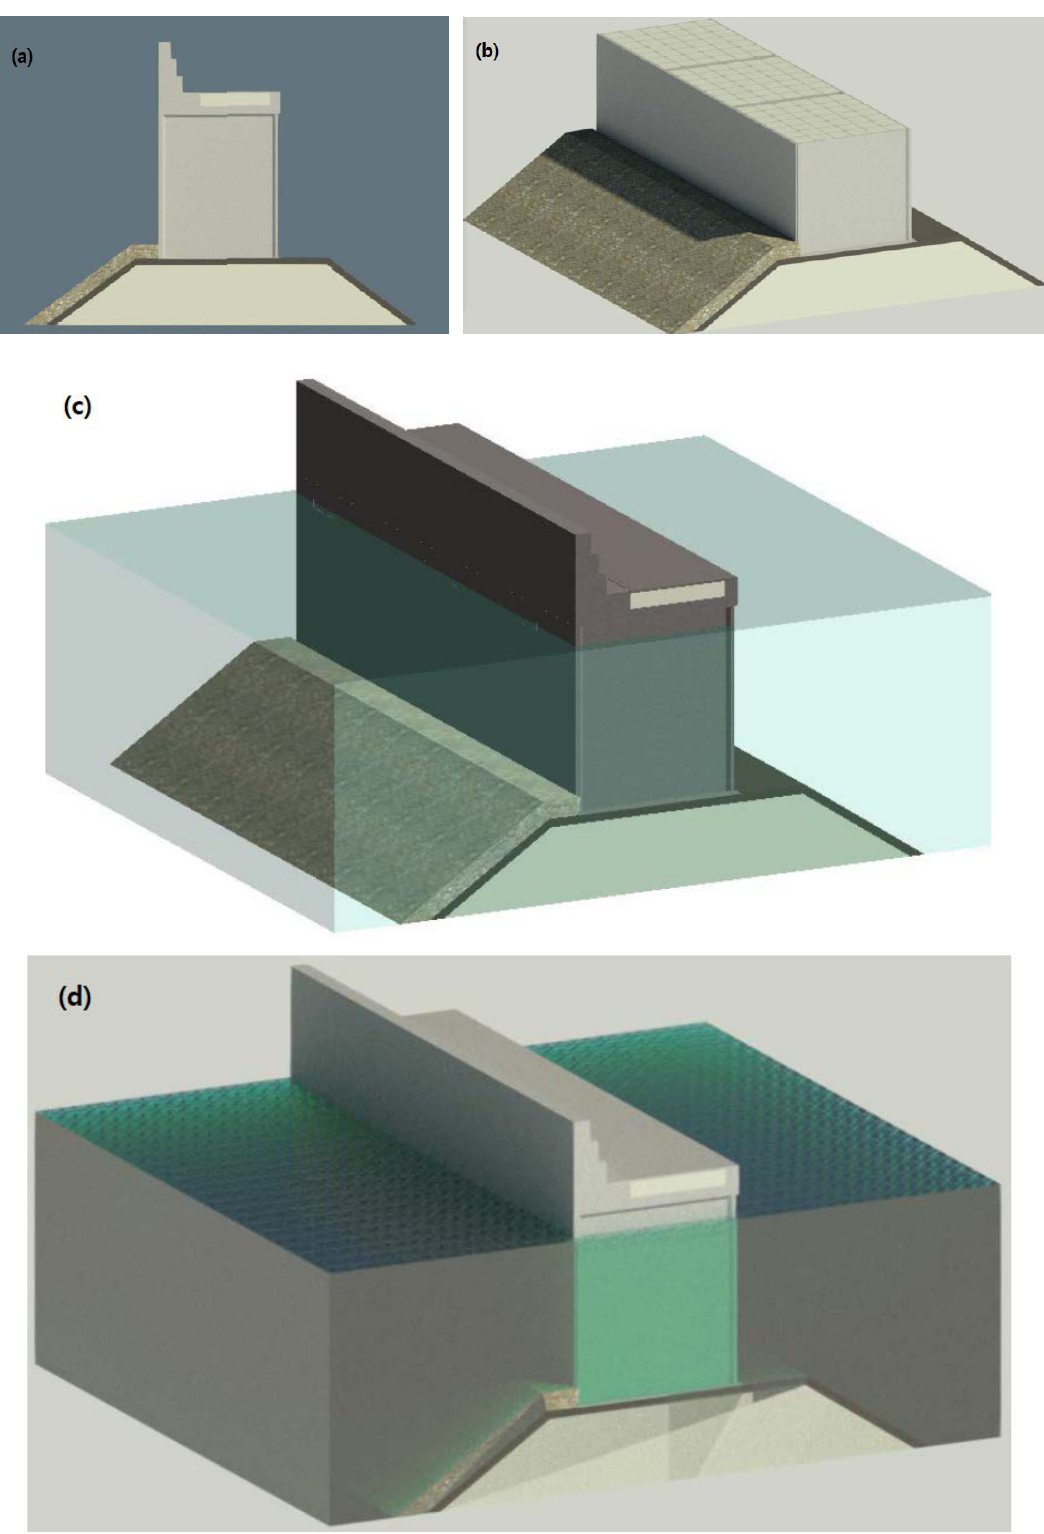
Figure 7. Revit model of the spur breakwater of the Outer Port of A Coruña (Langosteira): ( a ) front view; ( b ) diagonal view without sea level; ( c ) diagonal view with transparent sea level; ( d ) diagonal view with non-transparent sea level.